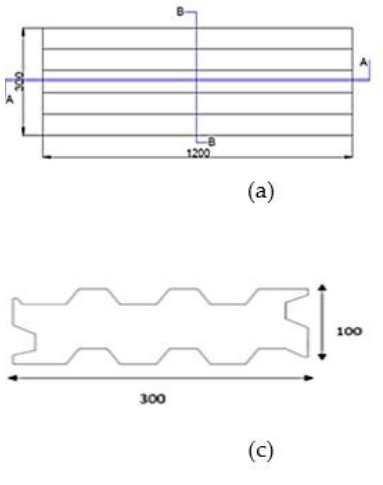
Figure 1. Overall dimensions of panel: ( a ) top view of the panel; ( b ) cross-section A-A; ( c ) cross- section B-B; ( d ) sample panels with a slot along the bents.